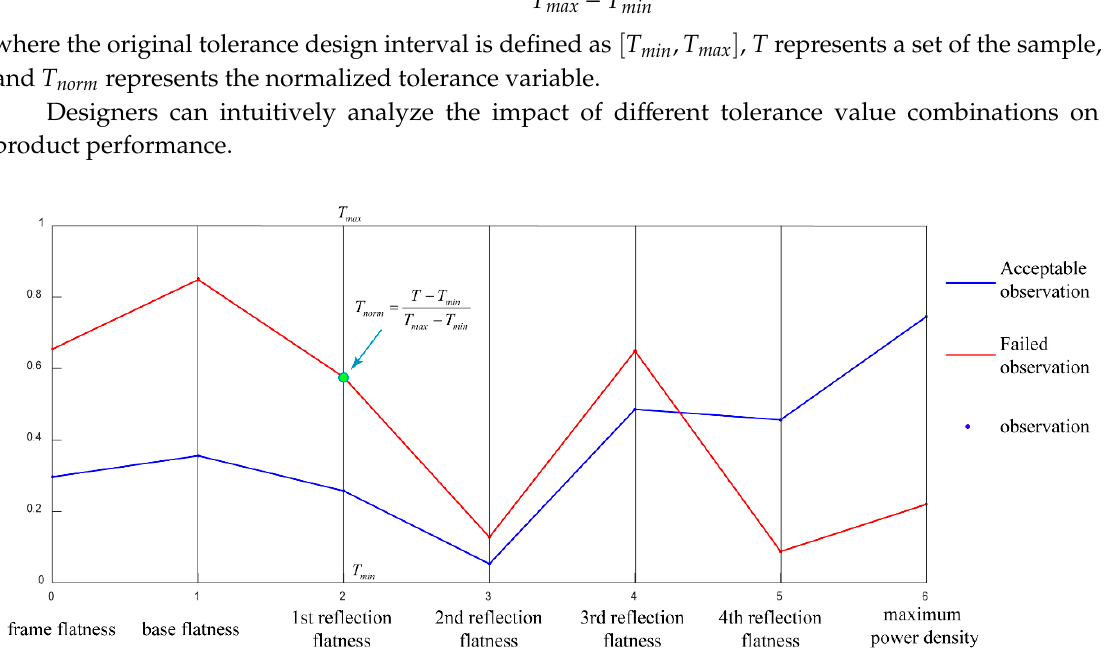
Figure 7. The parallel coordinates plot.